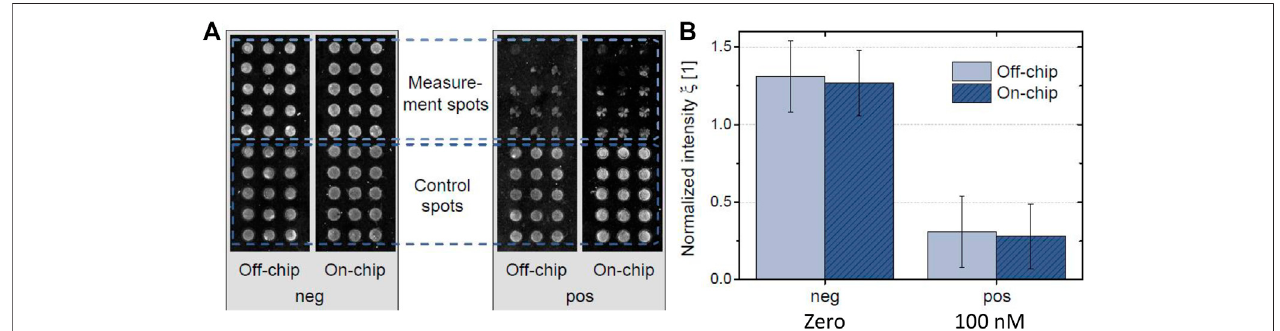
FIGURE 4 | Microarray response for non-spiked and 100 nM ACL spiked plasma samples using an automatic micro fl uidic system (on-chip) and manually static assay (off-chip). (A) Fluorescent readout images showing microarrays of non-spiked and 100 nM spiked sample in on-chip and off-chip assay. The arrays were separated into control (13BSA/As138 assay) and measurement (A2BSA/As233 assay) spots, in which the latest are sensitive to the analyte. (B) Normalized intensity for measurements without (negative that corresponds to non-spiked sample, zero) and with analyte (positive, sample spiked at 100 nM of ACL).